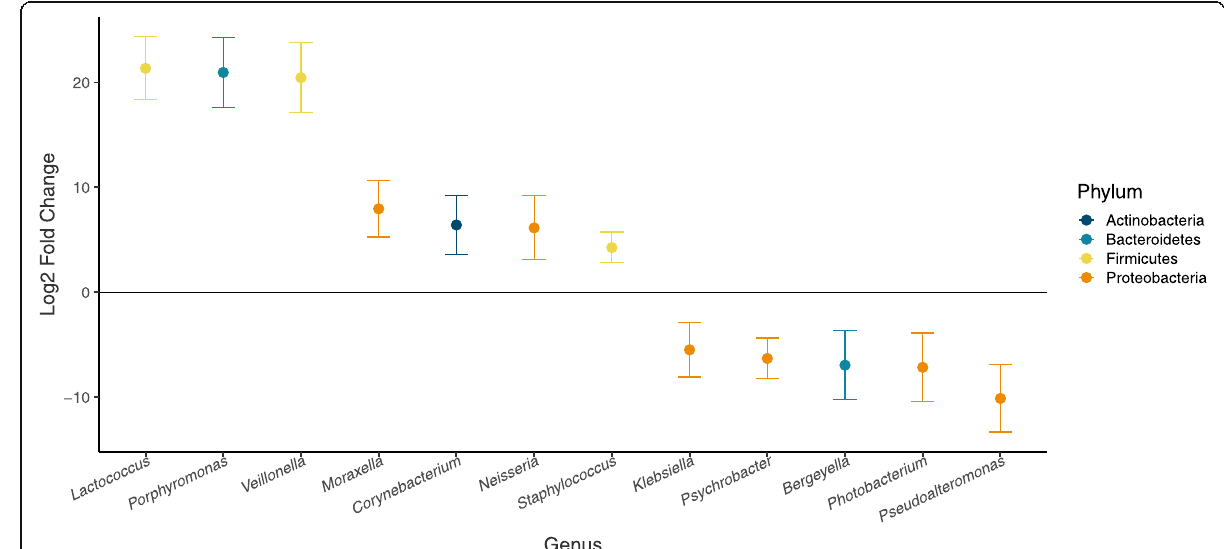
Fig. 6 Log-fold-change in abundance of potentially pathogenic genera that differed significantly between molting and non-molting individuals. The magnitude and direction of change is displayed as the change in abundance of microbes on non-molting individuals when compared to molting